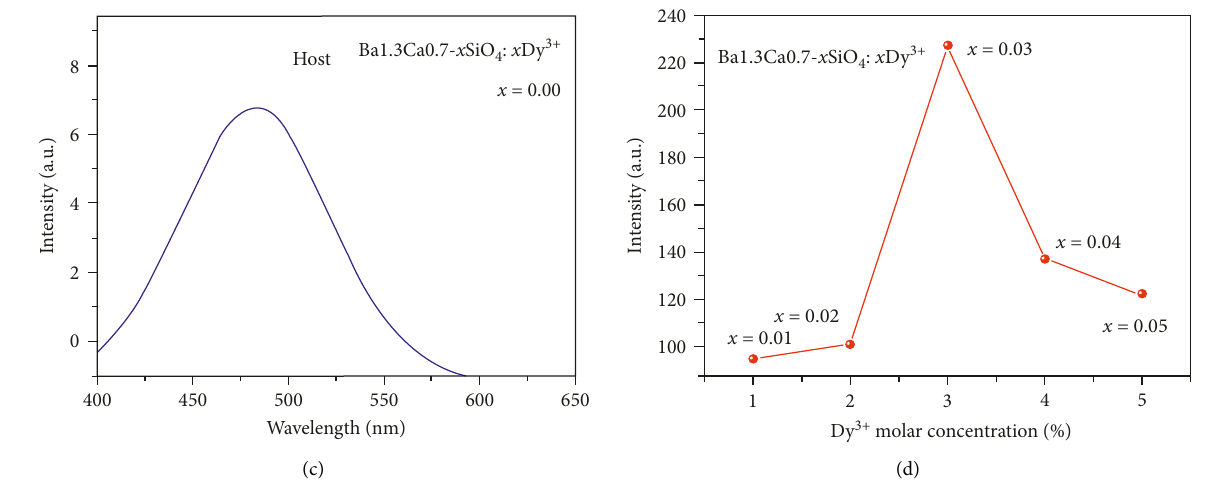
Figure 5: (a) Excitation spectra of Ba 3+ ( x � 0.01, 0.02, 0.03, 0.04, and 0.05). (b) Emission spectra of Ba1.3Ca0.7 − xSiO4: 1.3 Ca 0.7 − x SiO 4 : x Dy x Dy3+ ( x � 0.01, 0.02, 0.03, 0.04, and 0.05). (c) Emission spectrum of the host, Ba 1.3 Ca 0.7 SiO 4 . (d) PL intensity as a function of Dy 3+ molar concentration.